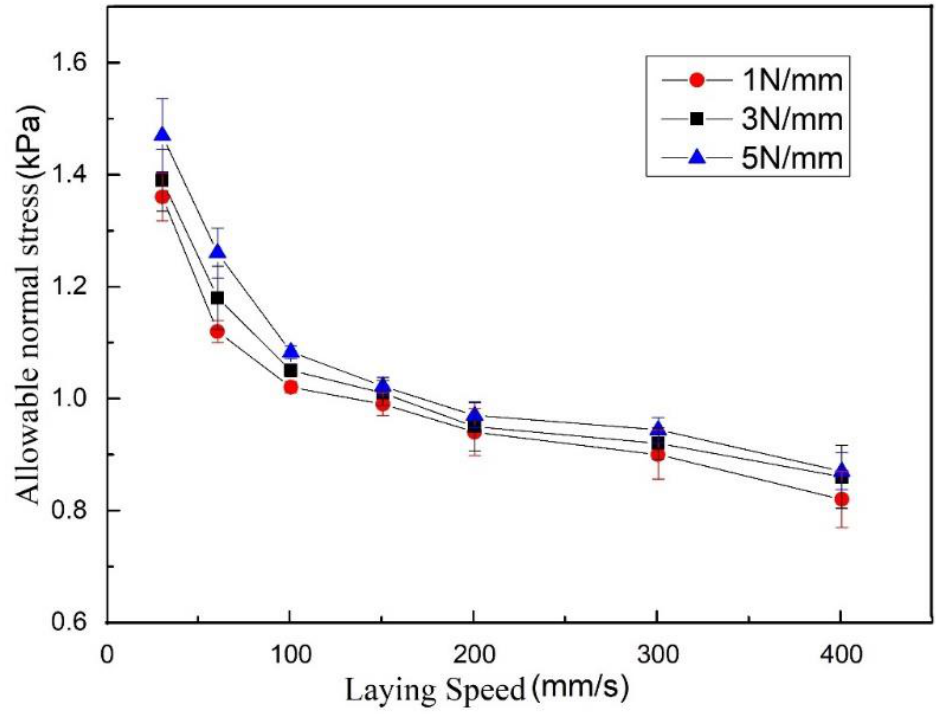
Figure 11. Laying speed/allowable normal stress curve of prepreg/metal laminate.